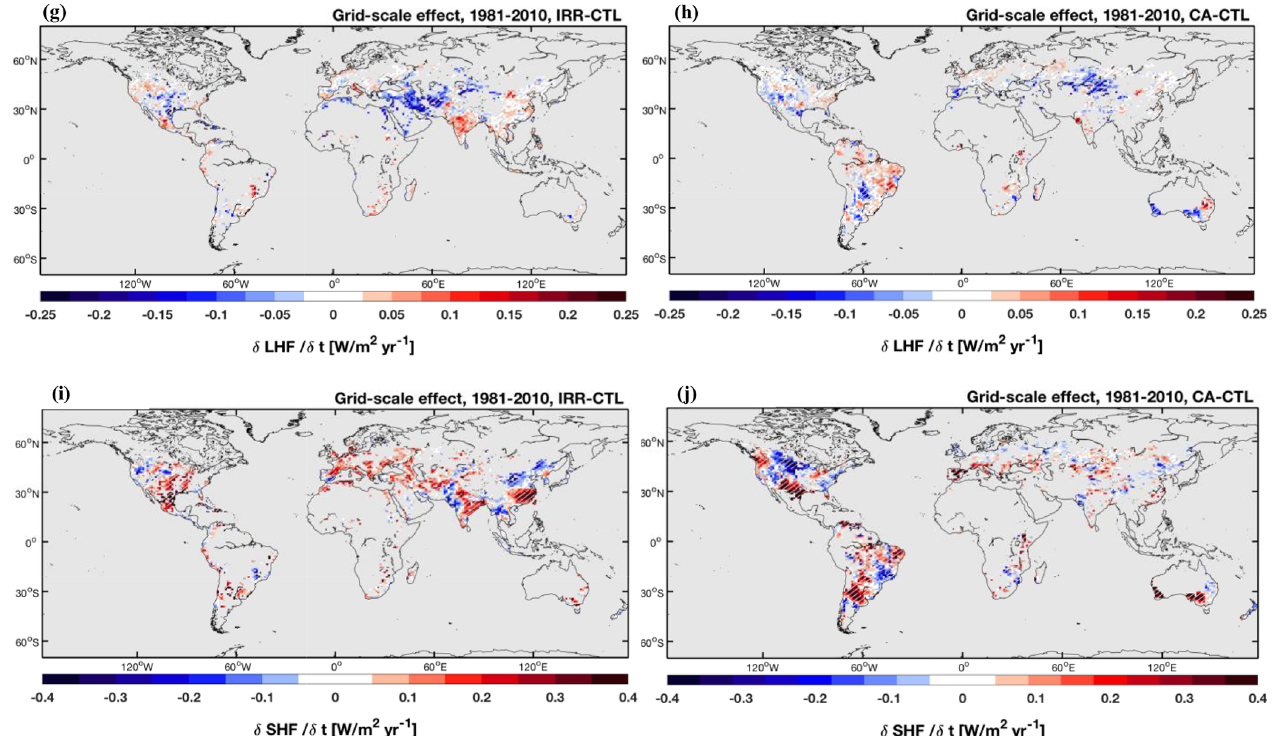
Figure 5. Grid-scale differences between the CTL and IRR ensemble (IRR minus CTL) (a, c,e, g, i) and between the CTL and CA ensemble (CA minus CTL) (b, d, f, h, j) . For T s (a, b) , TMQ (c, d) , ET (e, f) , LHF (g, h) and SHF (i, j) , displayed over irrigated/CA pixels for comparative purposes. Differences are based on the ensemble mean warming trends of each experiment for 1981–2010. Hatching denotes less than 10% change induced by the model on mean warming trends of lumped ensemble